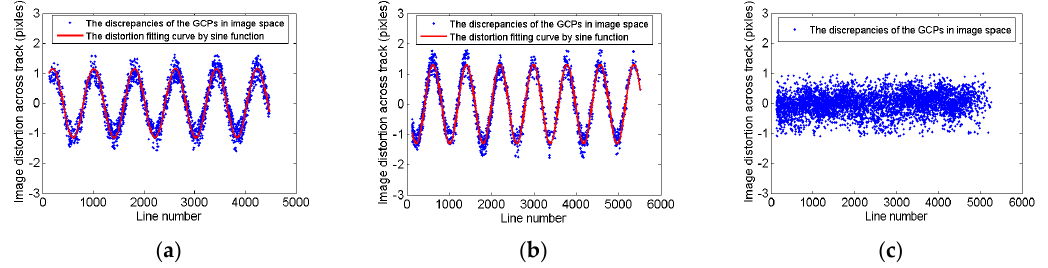
Figure 14. Image distortion across the track according to the ortho-images of ( a ) Scene A, ( b ) Scene B, and ( c ) Scene C. Table 9. Fitting results of absolute distortion across the track according to the ortho-images.